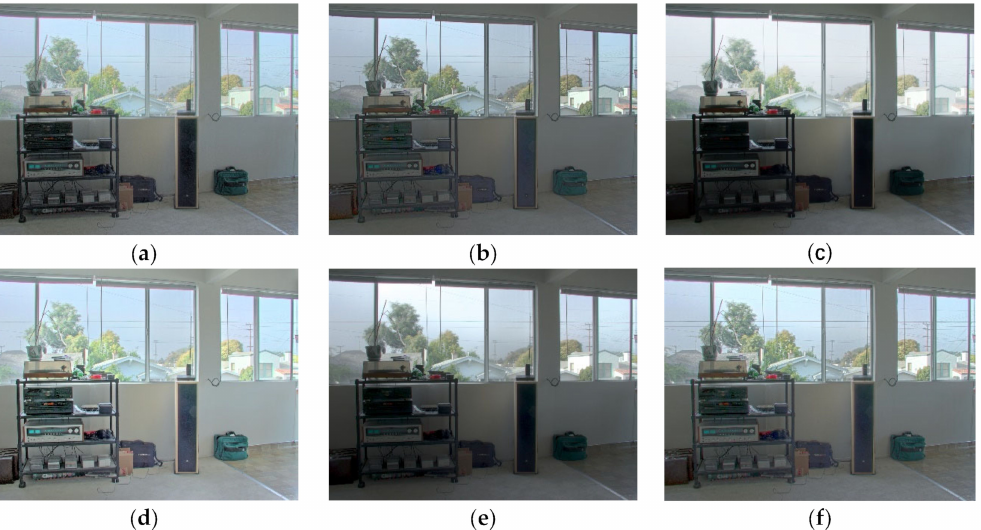
Figure 9. A comparison of tone mapping algorithms on the apartment image. ( a ) Result by TMO-Net. ( b ) Result by DeepTMO. ( c ) Result by Thai. ( d ) Result by L1-L0. ( e ) Result by Khan. ( f ) Result by our algorithm.